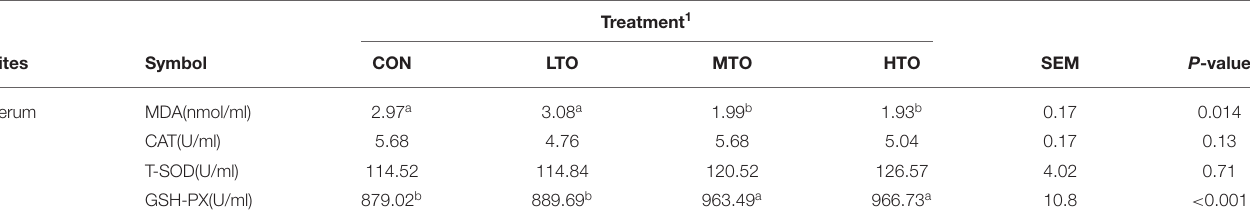
TABLE 6 | Effects of tea tree oil supplementation on antioxidant activity in finishing pigs ( n = 6).